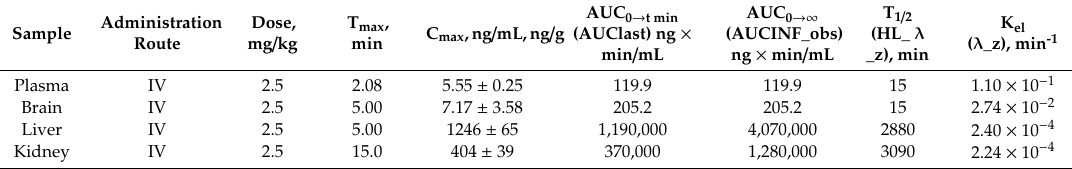
Table 3. Pharmacokinetic parameters for Les ‐ 3833 in male Balb/c mice.